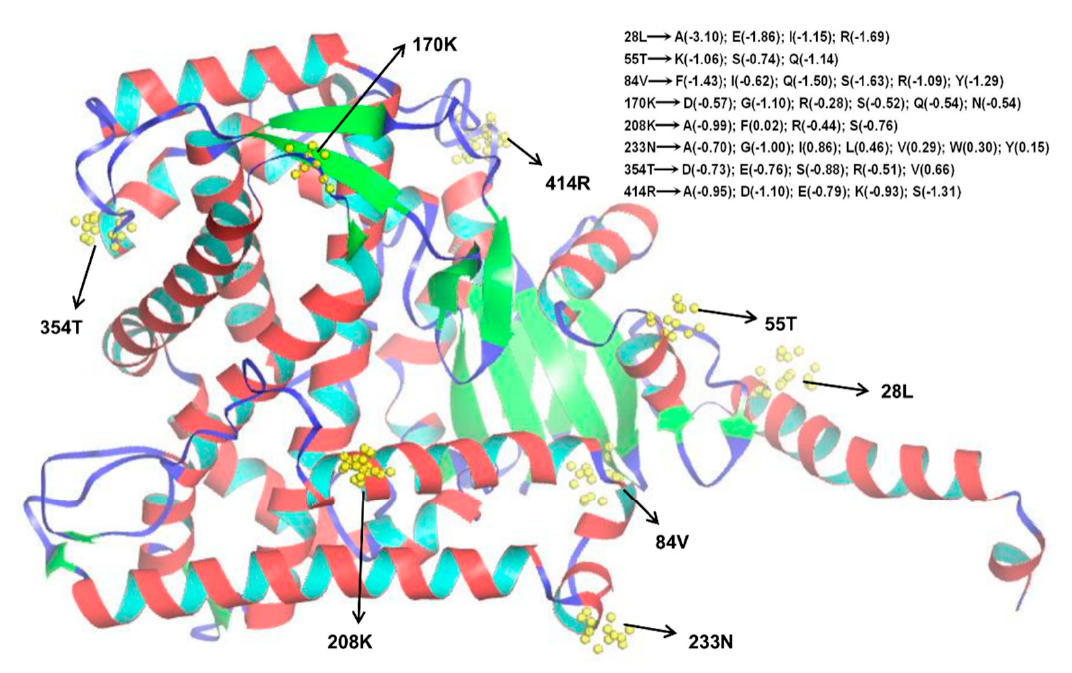
Figure 4. Distribution of positive selection sites among Group III CYP members predicted by the M5 model of nucleotide